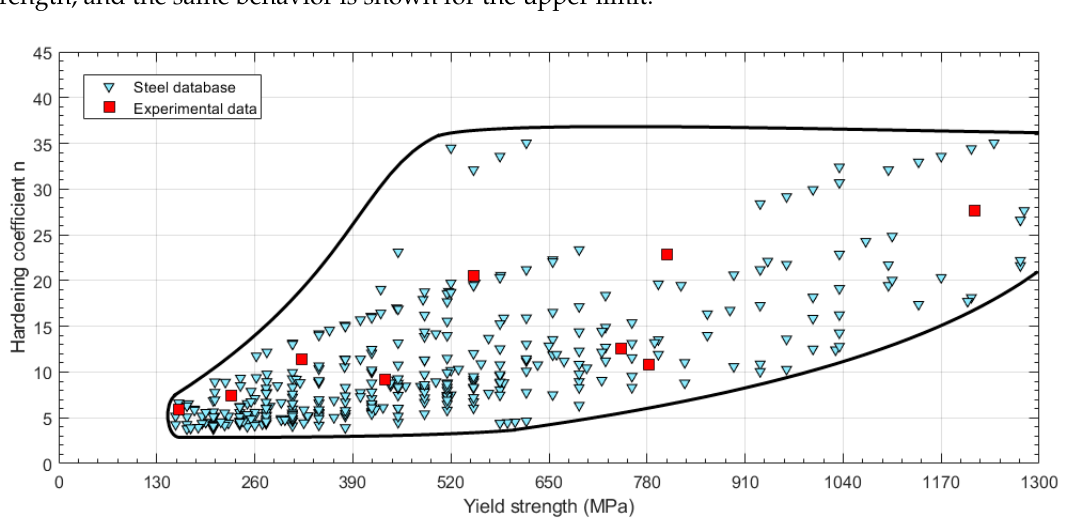
Figure 3. Steel database obtained from ASME BPVC-IIA and experimental data selection (hardening coefficient n vs. yield strength).